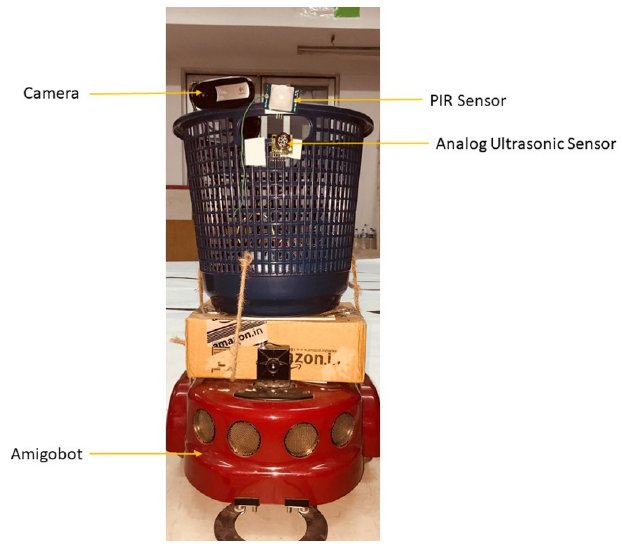
Figure 6. Sensors Setup on a Mobile Robot